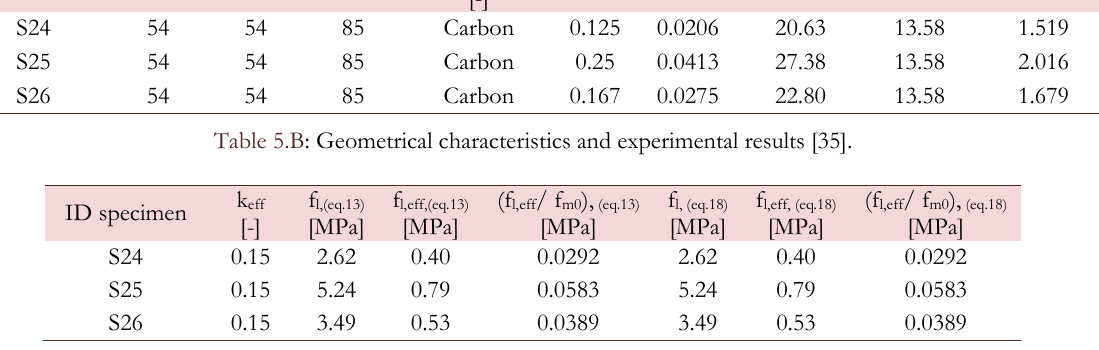
Table 6.B: Effective confining stress calculated according to Eqns. (13) and (18) for the experimental program [35].